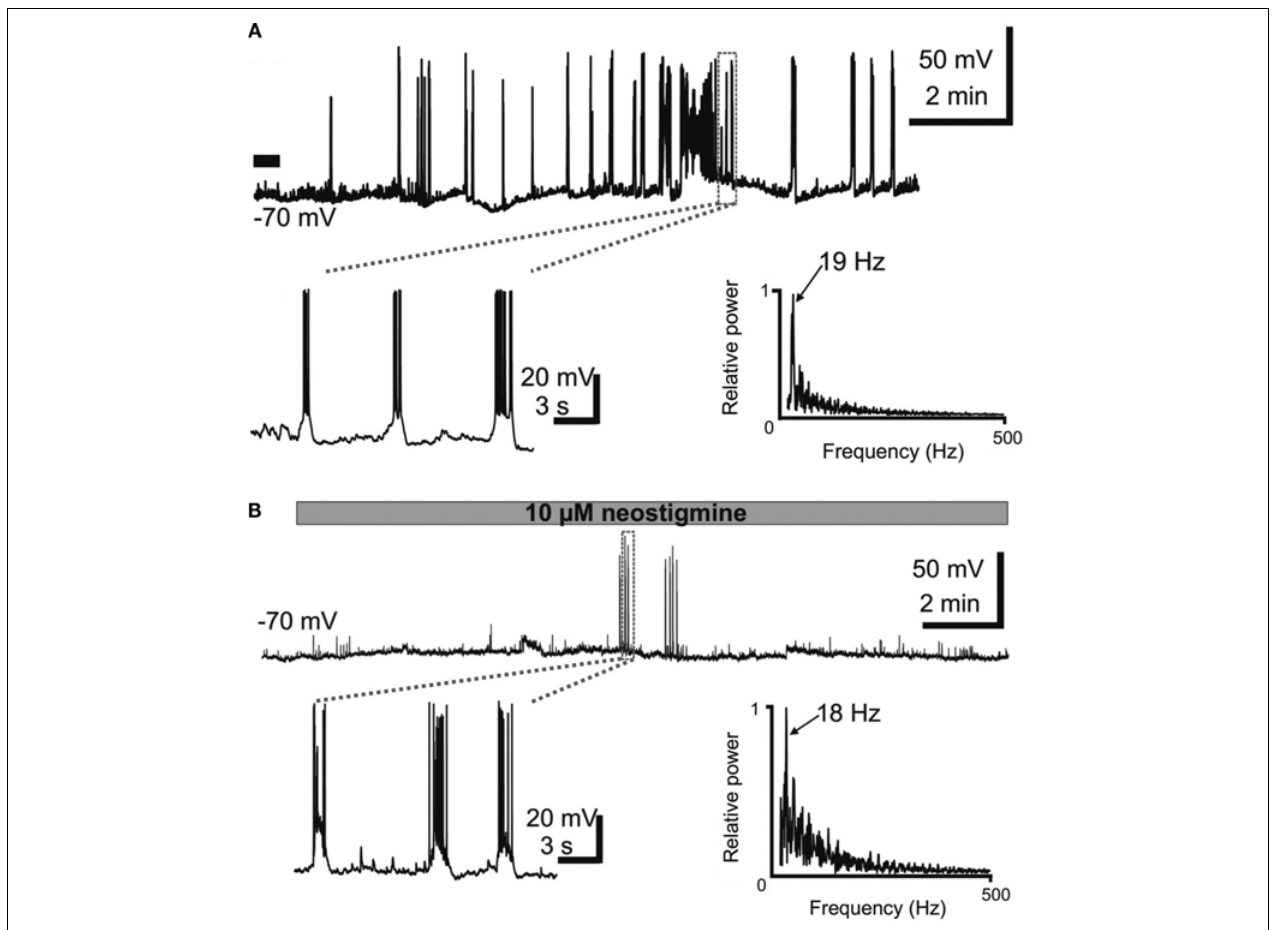
FIGURE 5 | Subplate neurons in newborn rat cerebral cortex reveal repetitive burst discharges upon activation of postsynaptic cholinergic receptors. (A) Current-clamp whole-cell recording from a P3 subplate cell at a holding potential of − 70 mV. Note the long-lasting burst discharge after a single 30-s long bath application of muscarine (marked by a black bar). The recording marked by the dashed box is shown at higher magnifi cation below. Frequency power spectrum of the action potential discharge within one representative burst from the trace above. (B) Current-clamp whole-cell recording from a P2 subplate neuron at a holding potential of − 70 mV